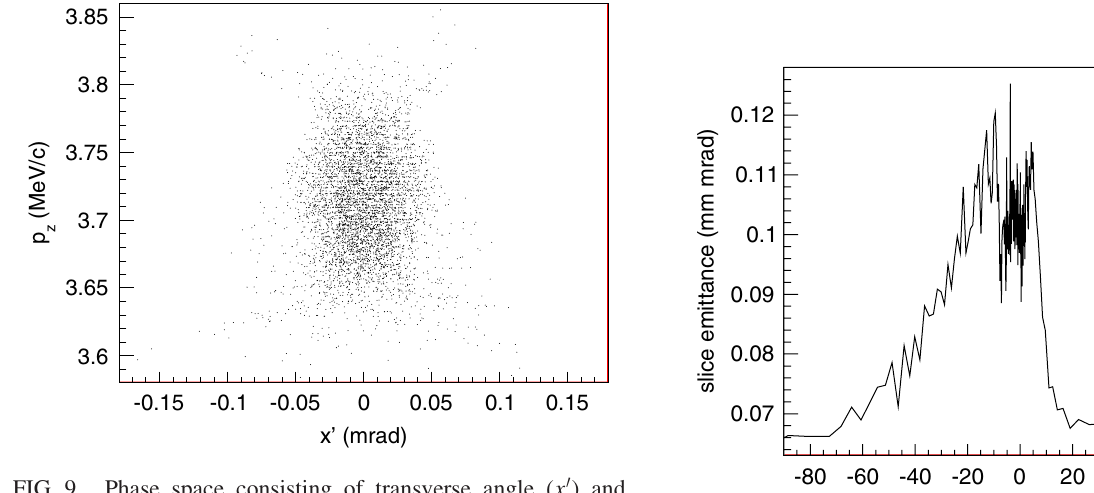
FIG. 9. Phase space consisting of transverse angle ( x 0 ) and longitudinal momentum ( p z ) of a beam at the sample location.